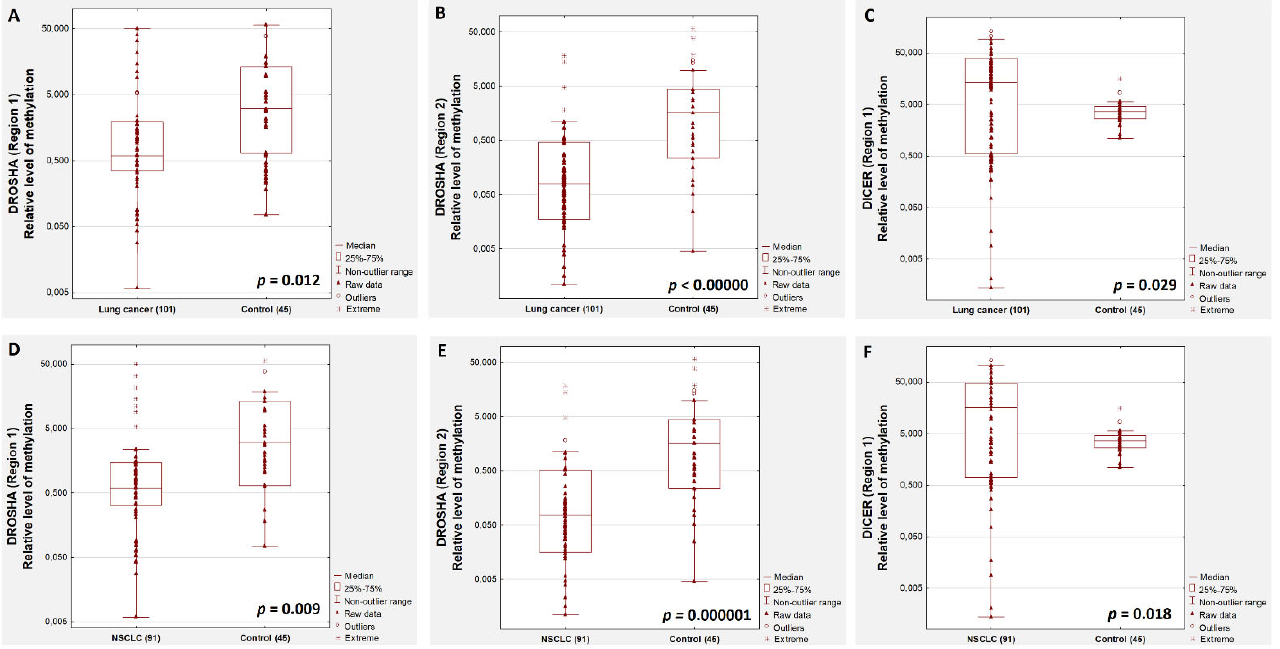
Figure 1. The relative methylation level of DROSHA and DICER genes in lung cancer patients ( A – C ) and NSCLC patients ( D – F ) compared with healthy individuals.